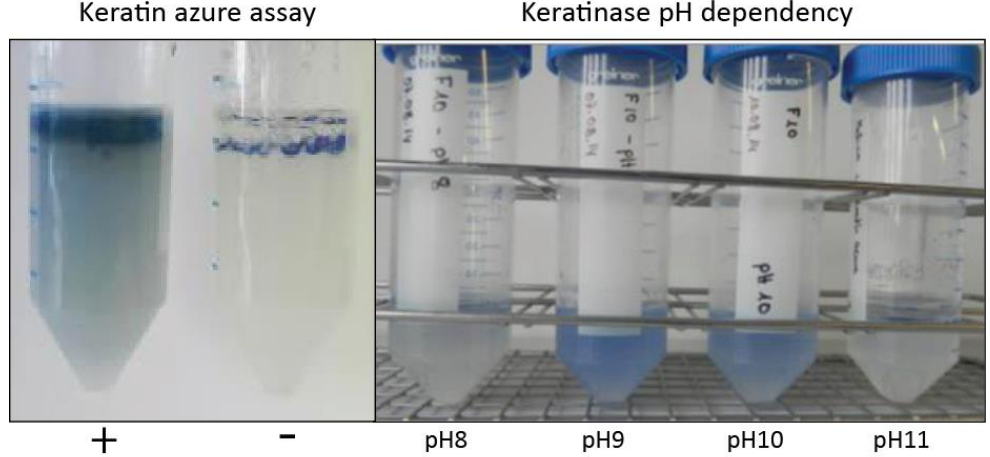
Figure 2. Keratin azure assay for bacterial strain keratinase activity. Individual bacterial colonies were inoculated in PBS buffer with the substrate keratin azure (blue-colored sheep wool) to allow the photometric quantification of keratinase activity, which releases a blue dye into the supernatant (left panel). Addition of bacterial culture medium without bacteria was used as a negative control (−). Addition of bacterial culture medium with highest keratinolytic activity was used as a positive control (+). Since keratinolysis is pH dependent, all isolates were tested in buffers with a pH range of 6–12 (right panel).